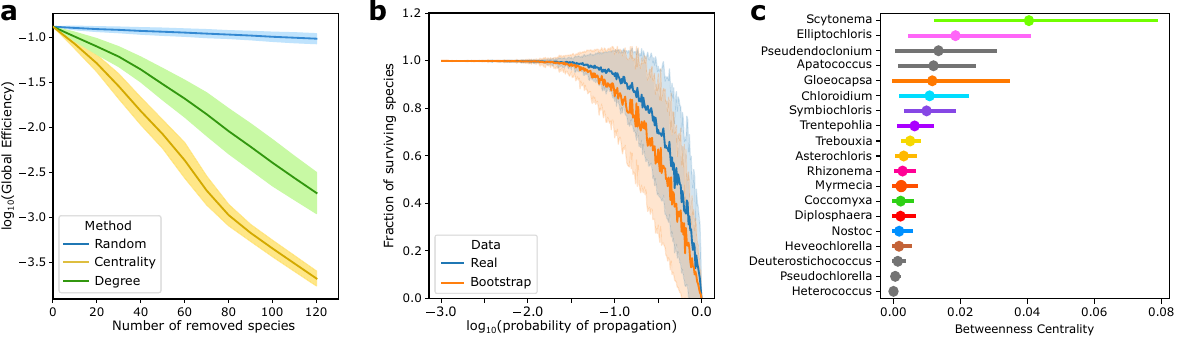
Figure 8. Guild contribution to network robustness. ( a ) Decay of global efficiency (and robustness) with increasing number of extinct species for different removal strategies. Centrality-based (yellow) removal of species affects the global path lengths and connectivity more than degree-based (green) or random removal of species (blue). ( b ) Surviving fraction of species in a cascading extinction event in the real (blue) and the bootstrapped (orange) data set. All simulations include 100 independent replicates in ( a ) and ( b ), with the solid lines representing the mean value of the distribution and the shaded area around it encompasses one standard deviation of the sample. In ( c ) we show the average betweenness centrality for the species in each guild, bars stand for the standard error in the